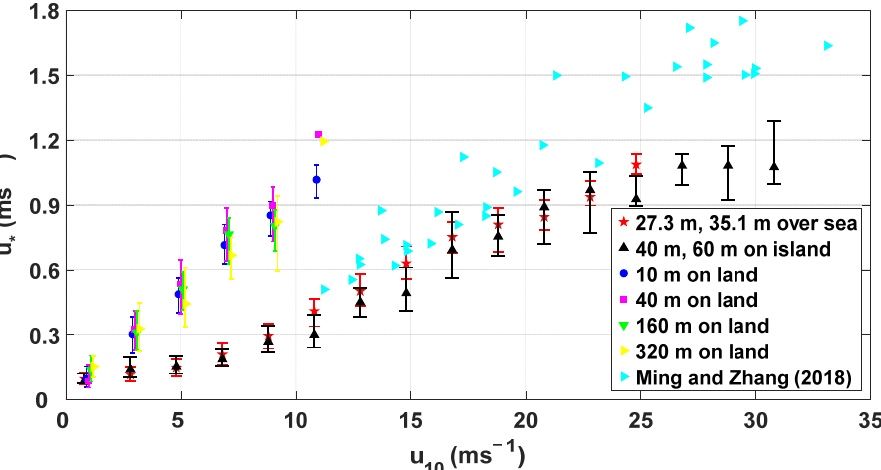
Figure 8. The values of the friction velocity ( u ∗ ) as a function of u 10 during typhoon events. The symbols and bars represent the median values and interquartile ranges, respectively. The u 10 bin size is 5 m s − 1 . The red pentagram symbols denote the observations from the tower over sea. The black up-pointing triangle symbols denote the observations from the tower on island. Other color symbols show the observations from the tower on land at different heights. Moreover, the cyan right-pointing triangles shown for comparison represent the data points reported in Ming and Zhang [29].